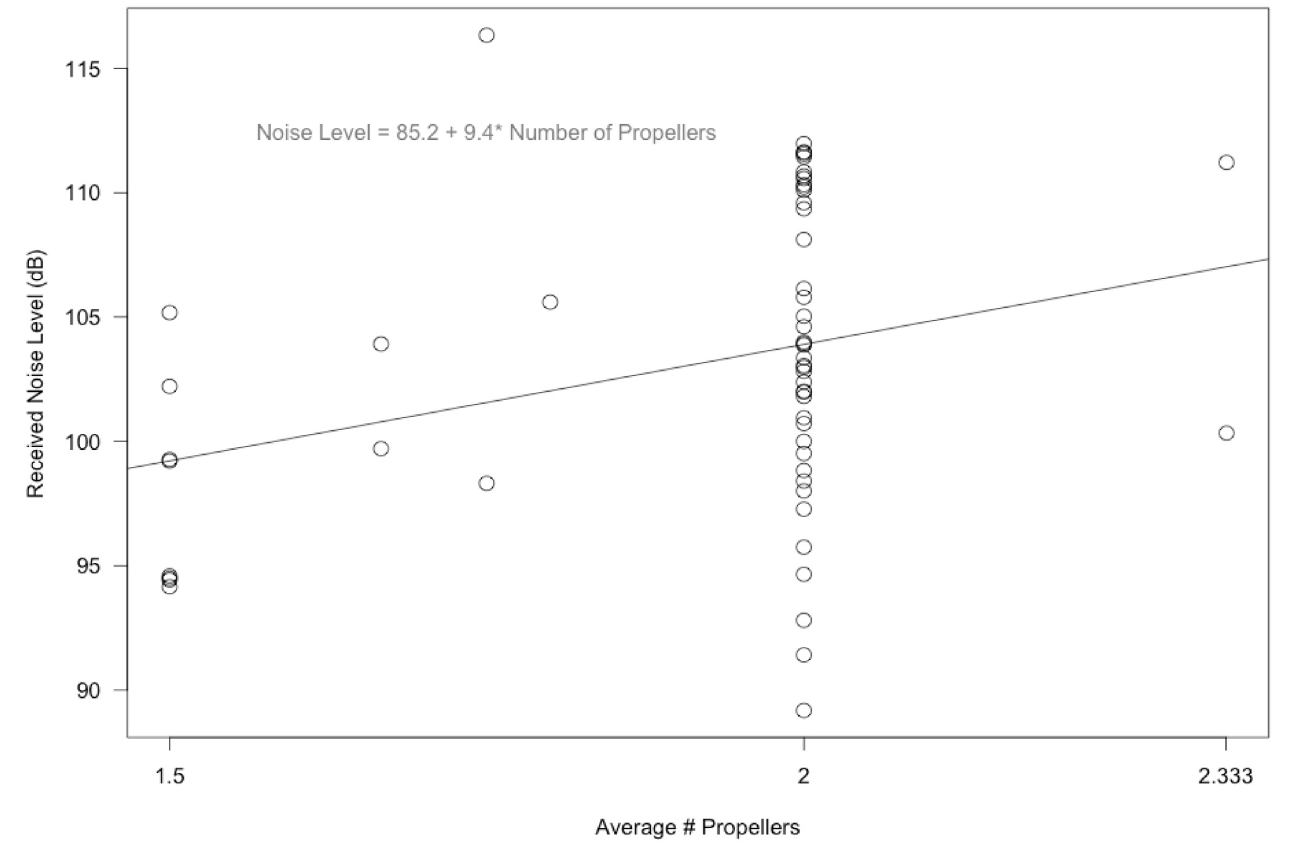
Fig 6. Noise levels and average number of propellers. Received noise levels (dB re 1 μ Pa) increased significantly with the average number of propellers on the vessels per interval (F1, 55 = 5.476, p = 0.023). There was a lack of variation in the number of propellers among vessels, as most vessels had two propellers. There were occasionally vessels with one or three propellers, but not enough of them to calculate a meaningful average number of vessels of one or